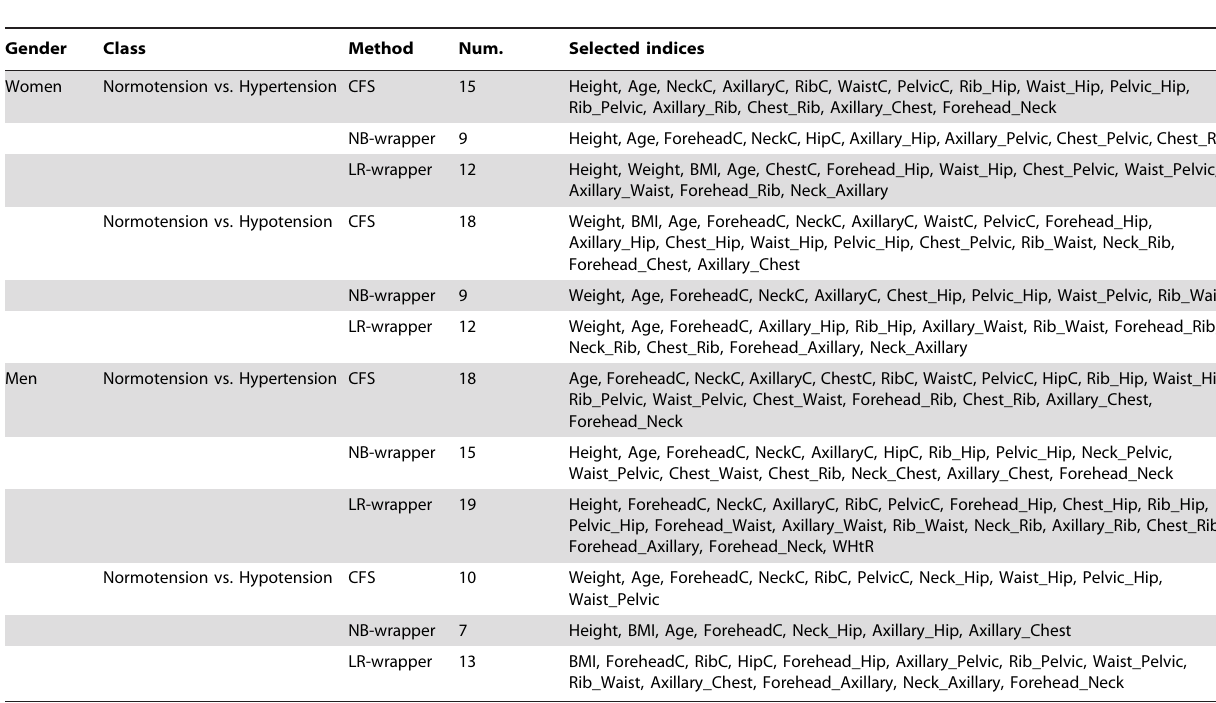
Table 5. Selected indices based on the CFS and wrapper-based variable selection techniques.